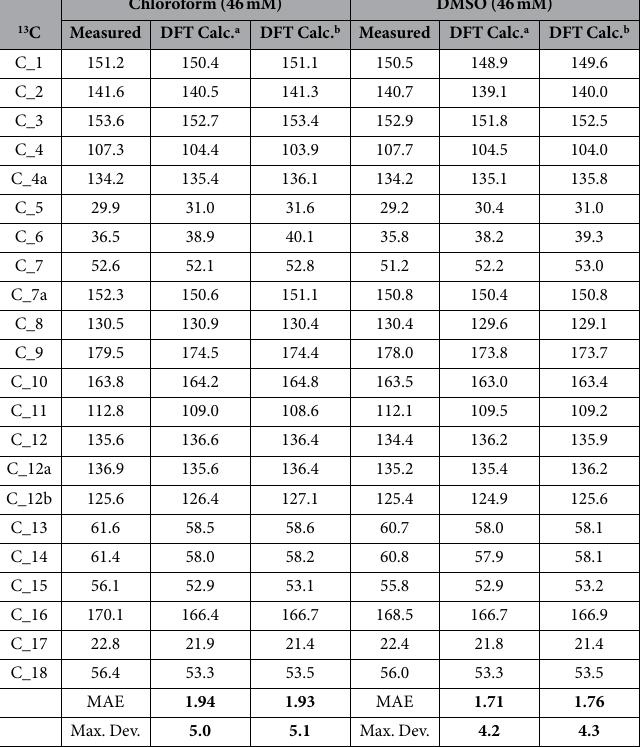
Table 2. 13 C experimental and DFT calculated chemical shifts for colchicine in chloroform and DMSO solvents using two functional and basis set combinations. a Mpw1pw91/6-311 + g(2d,p) with IEPCM chloroform or dmso solvation. b B3LYP/6-311 + g(2d,p) with IEPCM chloroform or dmso